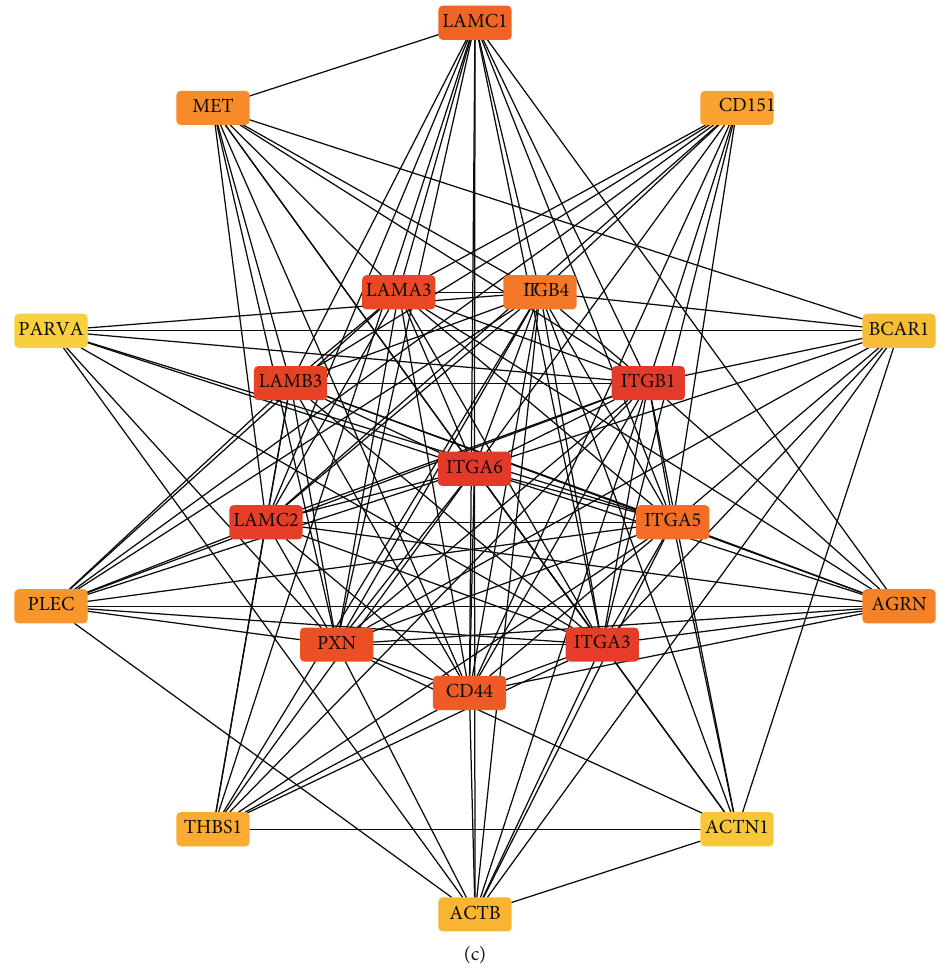
Figure 4: (a) GO enrichment analysis of coexpressed genes. In BP, we can see those coexpressed genes were enriched in cell-substrate adhesion, extracellular matrix organisation, extracellular structure organisation, cell junction assembly, and ameboid-type cell migration. Then, in CC, the coexpressed genes were enriched in cell-substrate junction, focal adhesion, and collagen-containing extracellular matrix. At last, in MF, the coexpressed genes were enriched in cadherin-binding, actin-binding, actin fi lament binding, and so on. (b) KEGG enrichment analysis of coexpressed genes showed that coexpressed genes were mainly concentrated in focal adhesion, PI3K-Akt signalling pathway, regulation of actin cytoskeleton, proteoglycans in cancer, ECM-receptor interaction, MAPK signalling pathway, small cell lung cancer, and bacterial invasion of epithelial cells. (c) Protein-protein interaction network of coexpressed genes. From this network, we can see the interaction in the coexpression mode of CD73. The more lines that connect, the more interactions, which means the gene may be more important. Besides, by using the “ CytoHubba ” plug-in, we screened out 20 hub genes according to the MCC